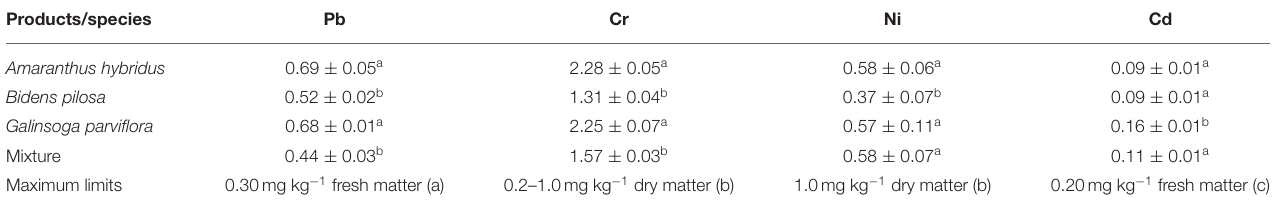
TABLE 4 | Metallic contaminants’ contents of lombi (mg/kg dry matter).